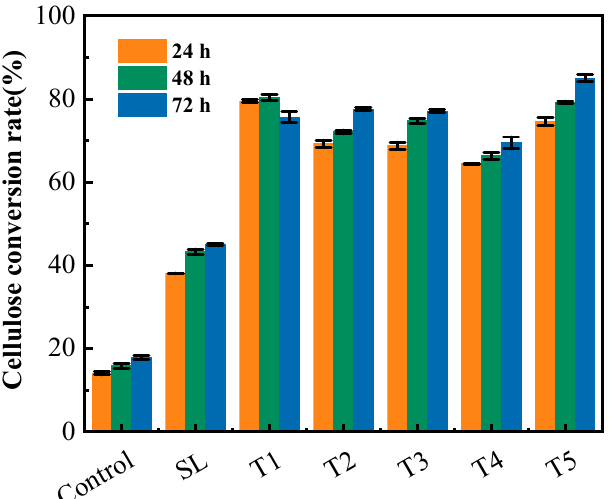
Figure 3. Effects of different compound additives on enzymatic hydrolysis of poplar. SL—sophorolipid, T1—methanol + sophorolipid (C1 + SL); T2—n-butanol + sophorolipid (C4 + SL); T3—n-pentanol + sophorolipid (C5 + SL); T4—isoamyl alcohol + sophorolipid (I5 + SL); T5—n-decanol + sophorolipid (C10 + SL). Experaments were determined in use with 2% ( w / v ) pretreated poplar as substrate with cellulase of 10 FPU/g substrate and W 63 crude enzyme protein of 40 mg/g substrate hydrolysis for 72